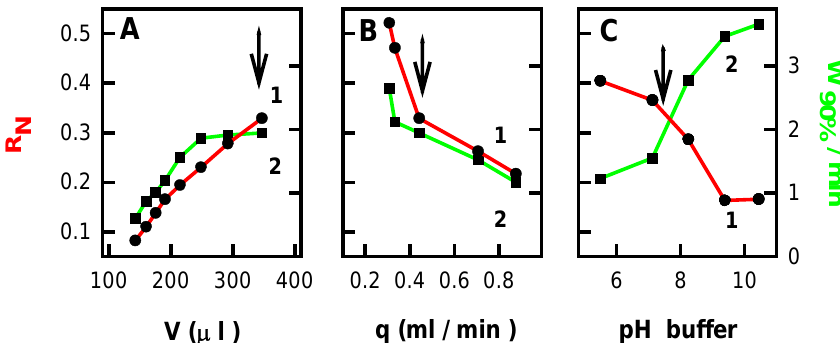
Figure 1. Effect of sample volume (A); flow rate (B) and pH (C), on the normalized reflected radiation intensity (curves 1) and on the peak width at 90% (W